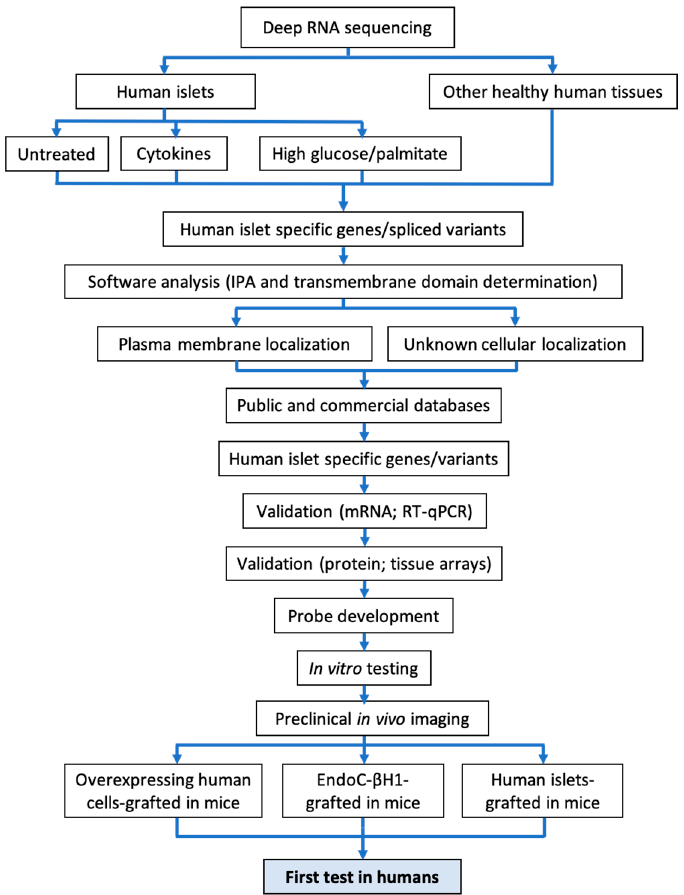
Figure 1. Step-by-step workflow presently used by our group to identify new beta cell biomarkers and to generate corresponding imaging probes. A schematic overview of the methodology used to mine RNA sequencing data for discovery of novel pancreatic islet biomarkers is shown. Transcripts differentially expressed in pancreatic islets are identified by comparing transcriptomes of human pancreatic islets against 16 different normal human tissues. Deep RNA sequencing analysis (>180 million reads, to allow identification of >80% splice variants) is performed on untreated human islet preparations or after treatment with pro-inflammatory cytokines (IL-1 β + IFN- γ or IFN- α ) or exposure to metabolic stress (high glucose and/or palmitate) to identify transcripts unaltered by the stressful conditions prevailing in diabetes. A software analysis (Ingenuity pathway analysis (IPA) analysis + transmembrane domain) is conducted on the generated hits to identify membrane-expressed proteins, potentially reachable with a probe. Once the biomarkers identified are validated at the mRNA and protein levels, one or more imaging probes are developed. After complete in vitro validation, the probes are tested for in vivo imaging on humanize mouse models grafted with different amounts of human beta cells.